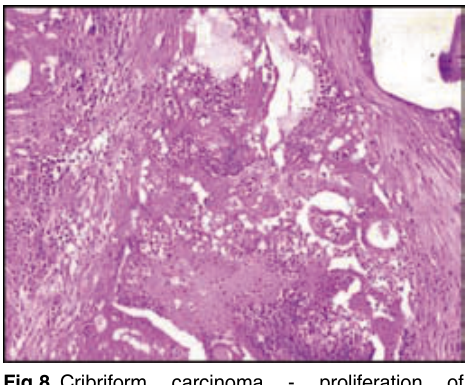
Fig.8. Cribriform carcinoma - proliferation of neoplastic epithelial cells forming a sieve-like arrangement